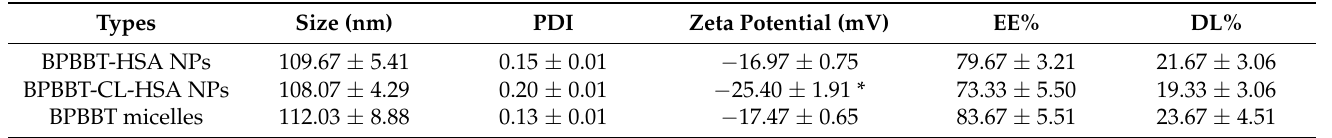
Table 1. Characterization of different types of BPBBT NPs a